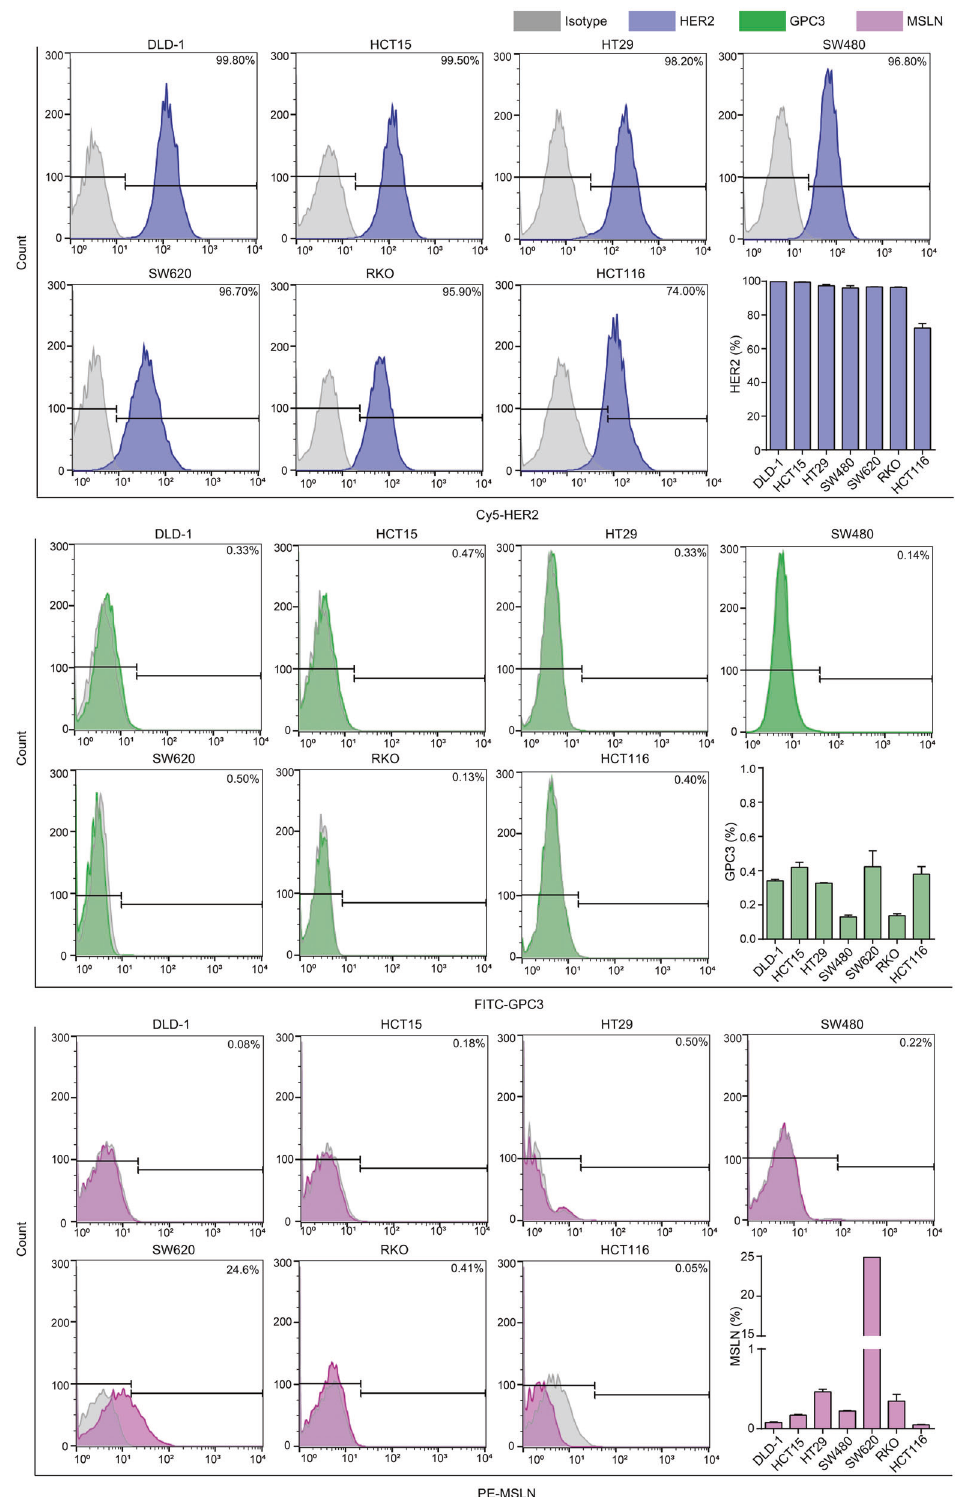
Fig. 1 Surface expression levels of three candidate target proteins. Upper: Expression of HER2 in 7 CRC cell lines as detected by fl ow cytometry. Medial: Expression of GPC3 in 7 CRC cell lines as detected by fl ow cytometry. Lower: Expression of MSLN in 7 CRC cell lines as detected by fl ow